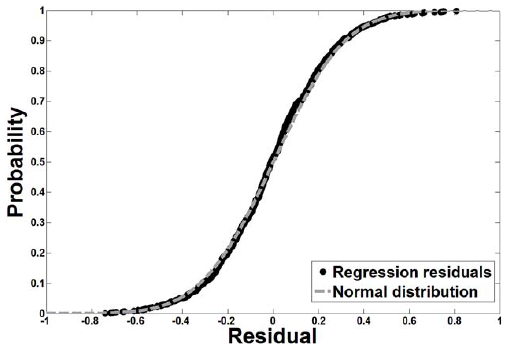
Fig. 4. Normality test of the residuals of the regional regression equation between the standardized peaks ( q) and standardized vol- umes ( v) .